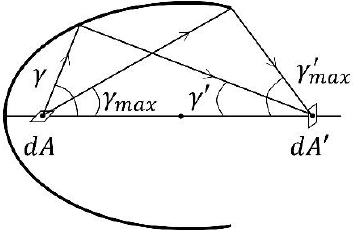
Figure 2. Schematic representation of multi-channel reflector.